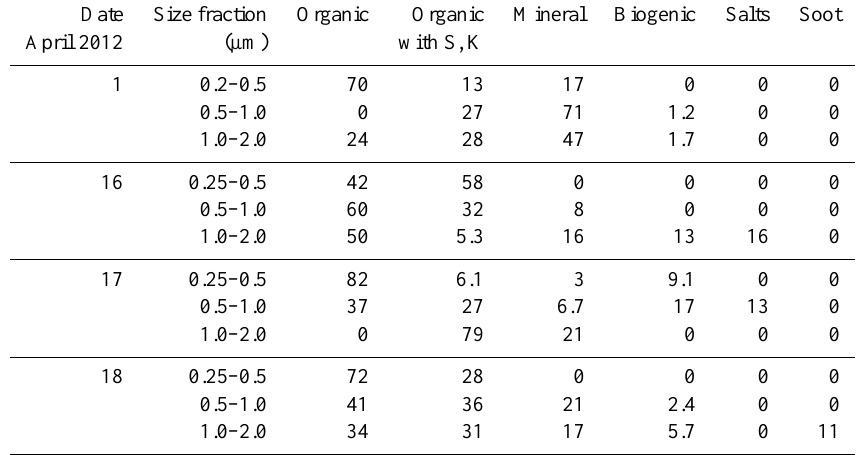
Table 8. Relative abundance of single particle types obtained at top of the walk-up tower in April 2012 (in percent). Date Size fraction Organic Organic